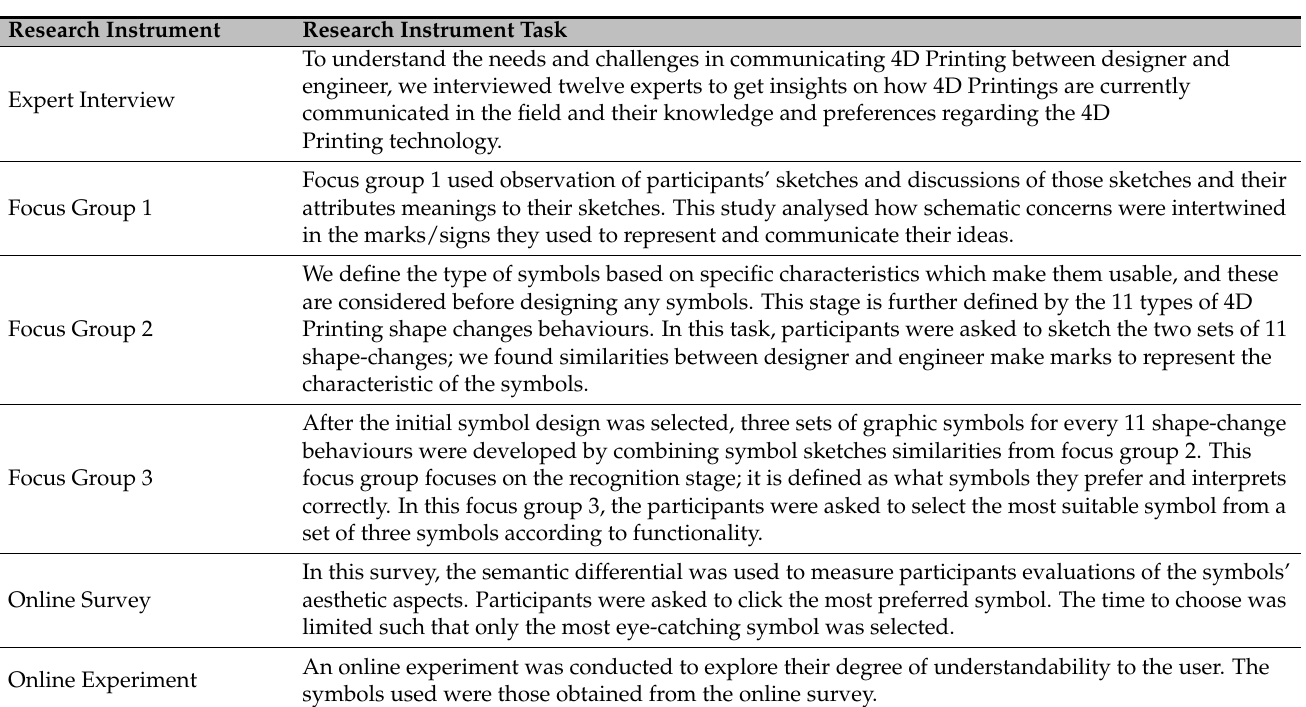
Table 5. List of the research instruments and tasks for the 4D Printing symbol